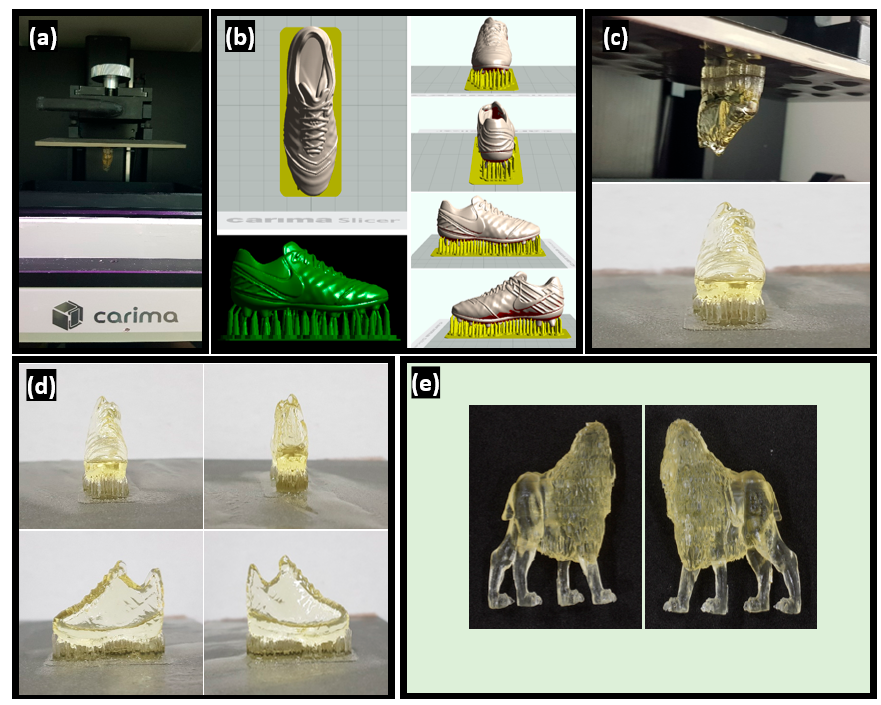
Figure 5. 3D printing process: ( a ) 3D printing using the DLP (Digital Light Processing) method, ( b ) slicing of target structure using the Carima Slicer; ( c – e ) final printed 3D